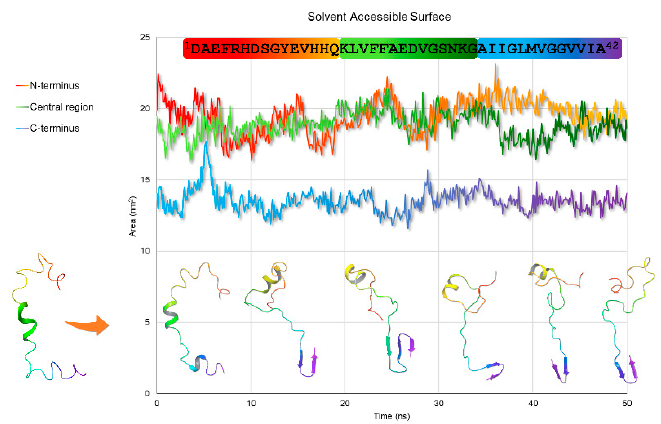
Figure 6. Snapshots of A β (1–42) trajectory throughout 50 ns MD simulation (on the bottom) super- imposed to the solvent-accessible surface graph (on the top), according to the time step (ns) they were taken. The ribbons are colored in rainbow hue by atom position, from N-terminus (red) to C-terminus (purple).